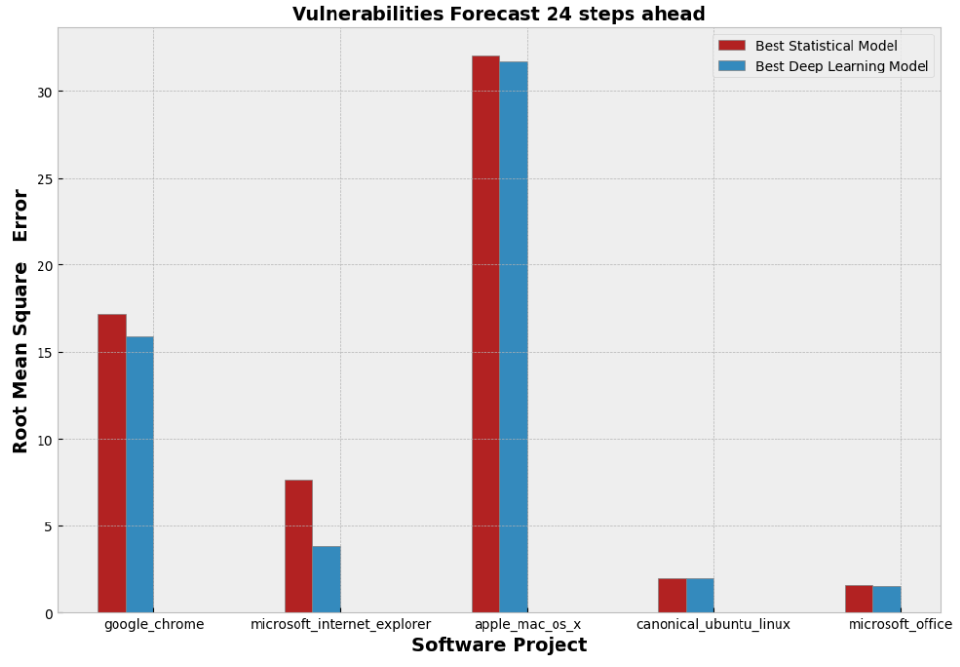
Figure 10. Comparison of the best statistical and deep learning models per project in terms of Root Mean Square